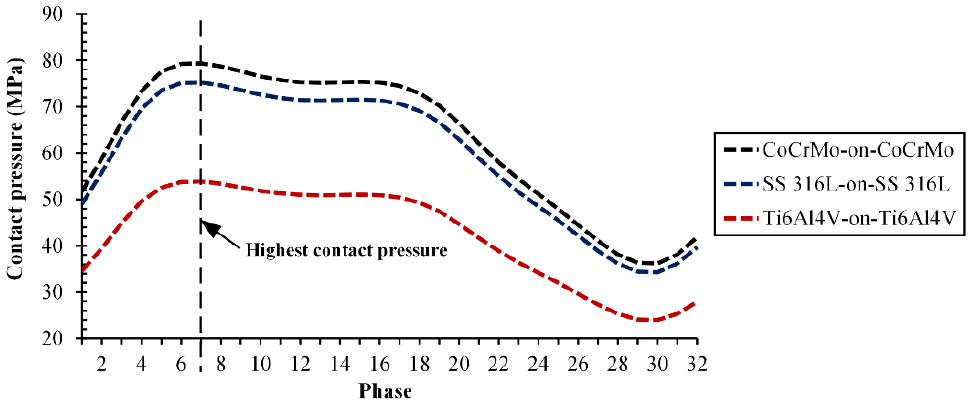
Figure 4. Comparison of the maximum contact pressure with the published results of Jamari et al. [24] and Hertzian contact [34].